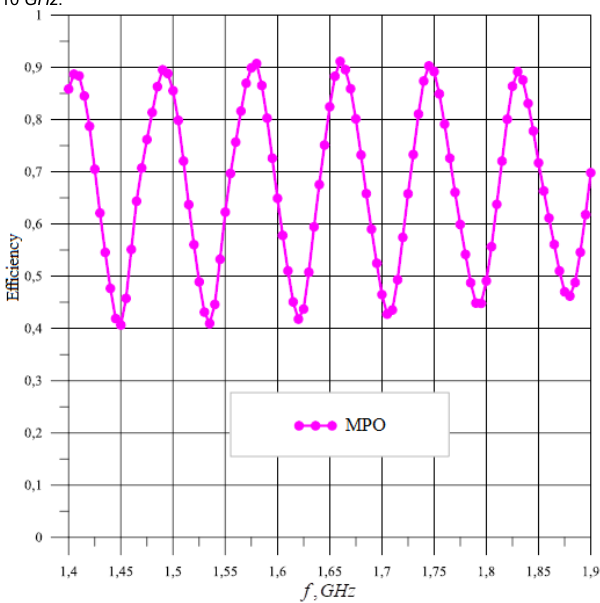
FIGURE 8. Estimated surface utilization factor in the frequency range from 1,4 to 1,9 GHz